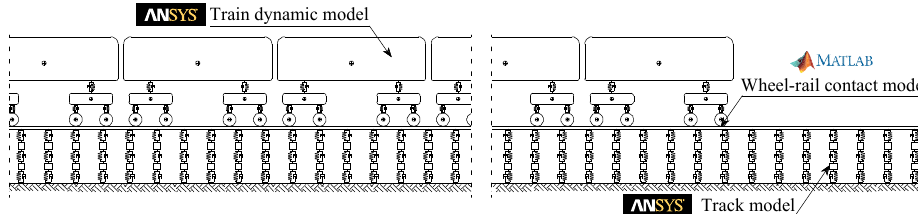
Figure 4. The modeling of train-track interaction.